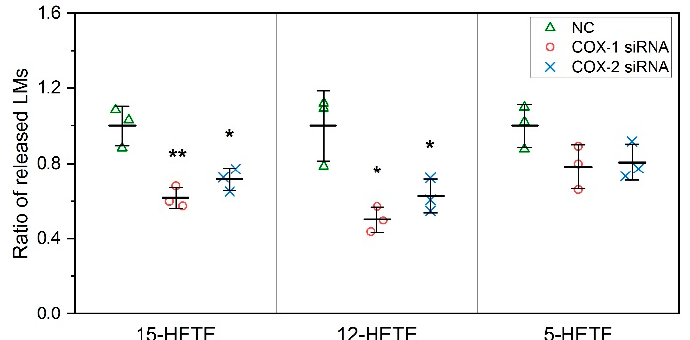
Figure 3. Knockdown of COXs reduces the levels of hydroxyeicosatetraenoic acids (HETEs) released by primary muscle cells. The levels of 12-HETE and 15-HETE, but not 5-HETE are significantly a ff ected by the downregulation of gene expression of both COX-1 and COX-2. n = 3, * p < 0.05 and ** p < 0.01 compared with